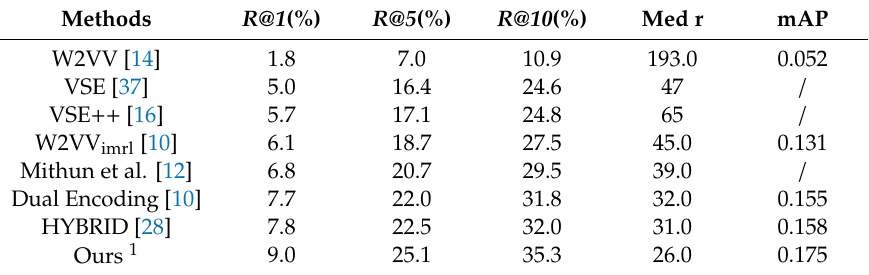
Table 4. State-of-the-art on the MSR-VTT